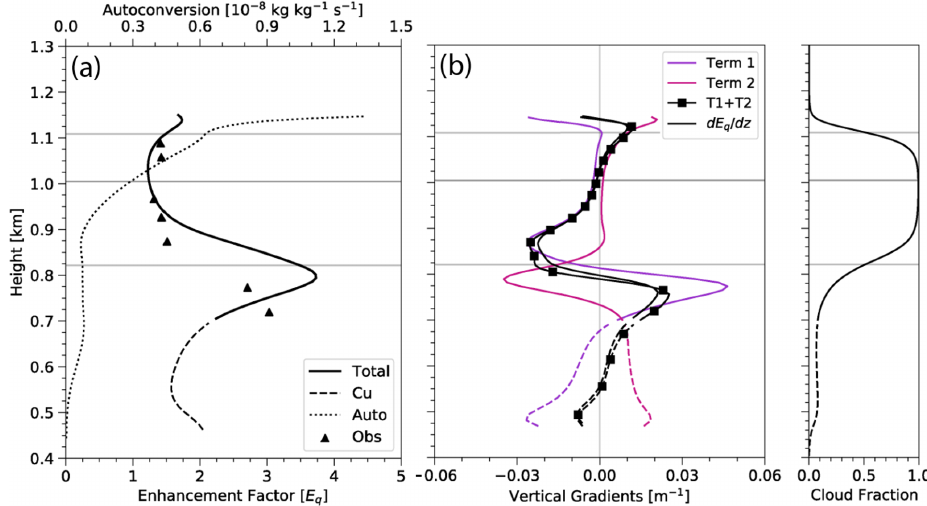
Figure 8. Vertical profiles of the horizontally averaged (a) enhancement factor E q and autoconversion and (b) the derivatives of the enhance- ment factor E q . As in Fig. 7, the dashed lines represent the cumulus cloud layer. Term 1 and Term 2 are calculated as defined in Eq. (3). The gray lines are as in Fig.